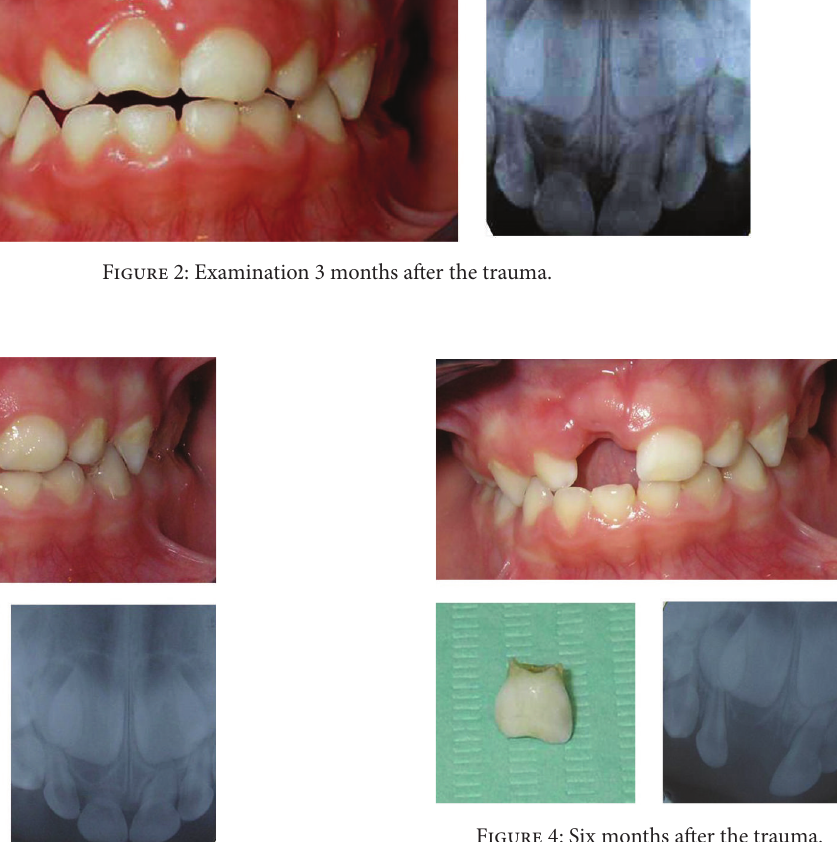
Figure 4: Six months after the